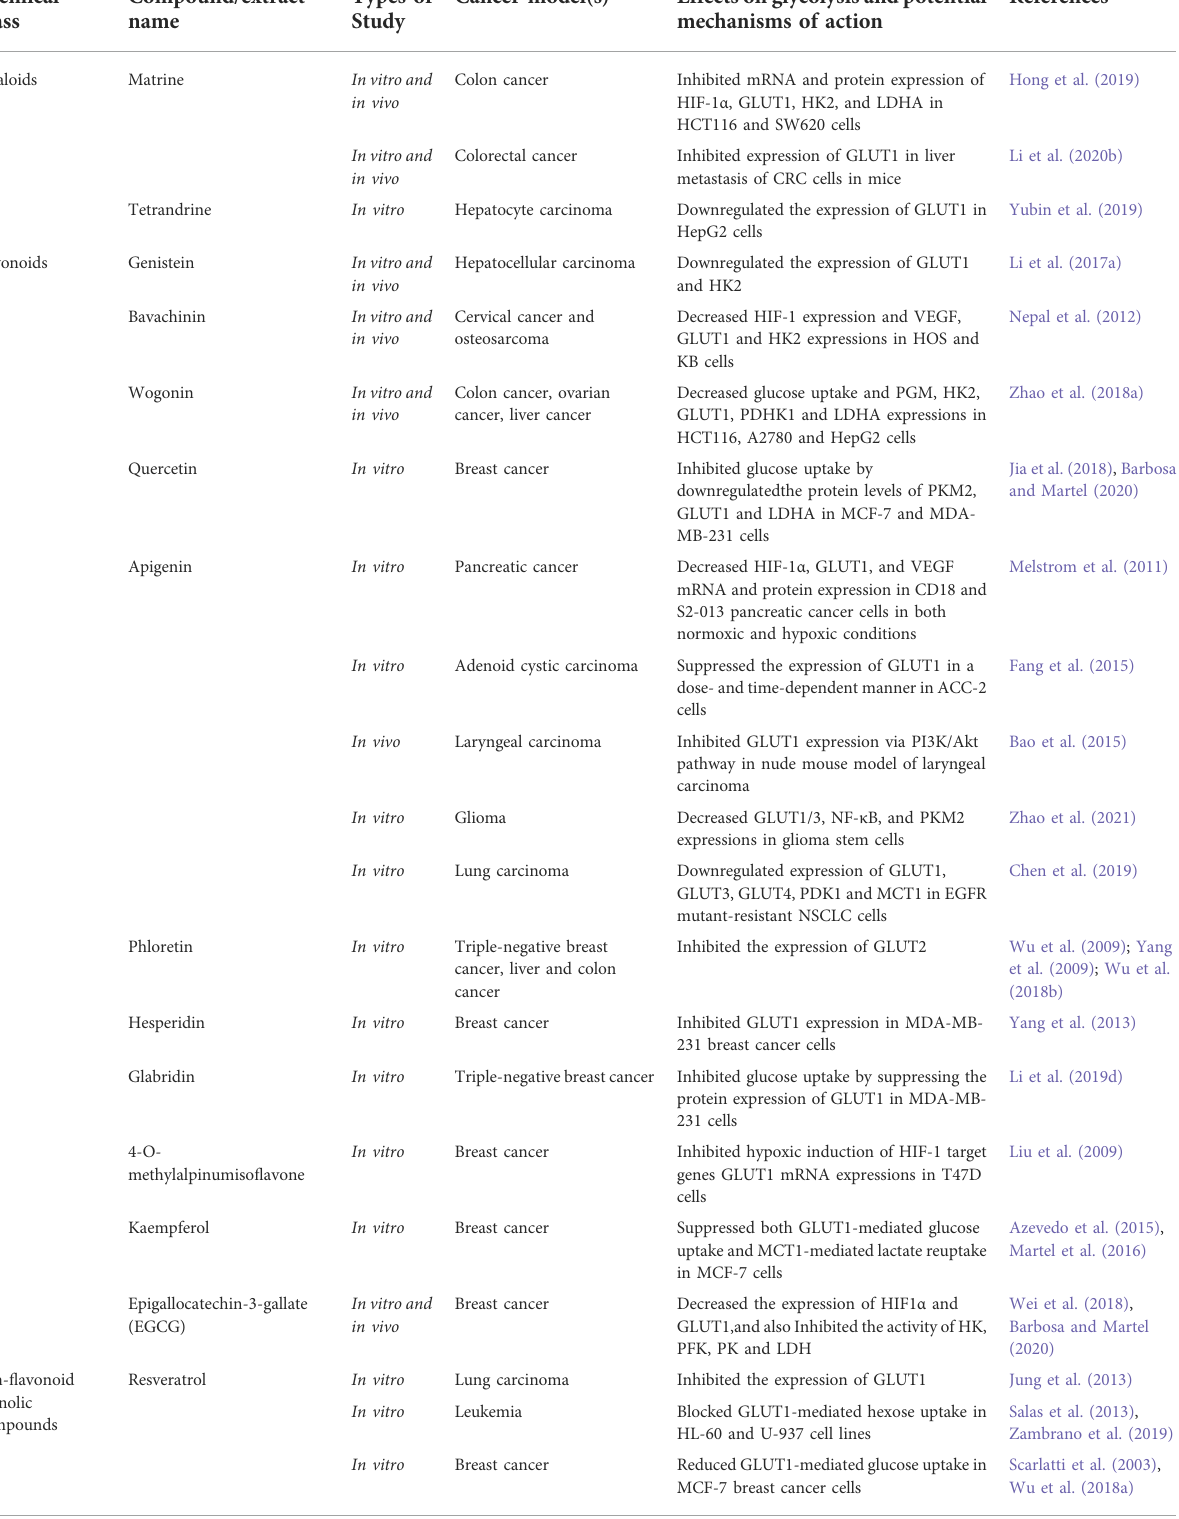
TABLE 5 Natural compounds target glucose shuttling